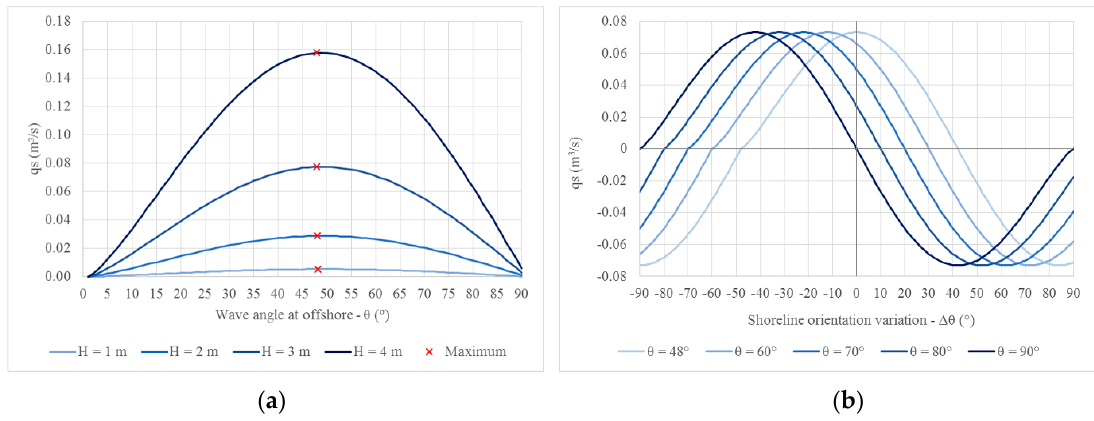
Figure 3. Longshore sediment transport rate according to CERC formula: Sediment transport for different wave heights, depending on the wave angle offshore ( a ); sediment transport for different wave angles offshore (H = 3 m), depending on the shoreline orientation variation due to the nourishment —Δθ positive angles are in a clockwise direction ( b ).